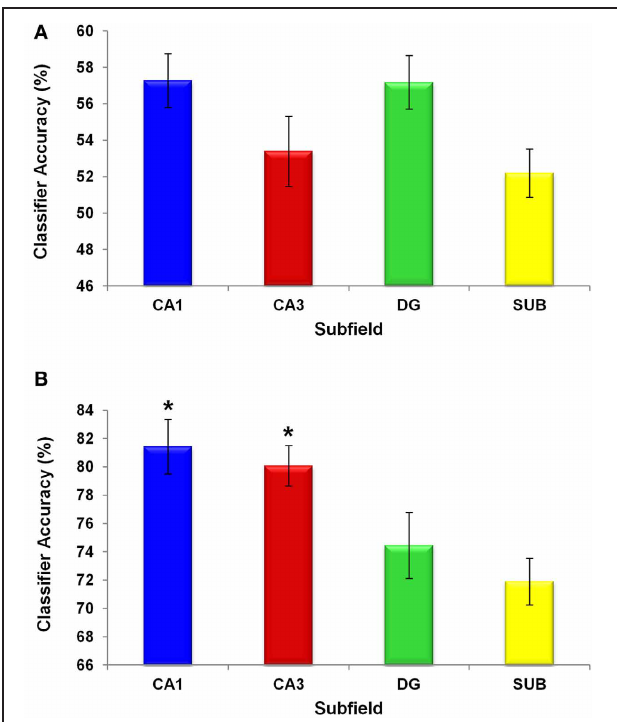
FIGURE 7 | Classifier performance in hippocampal subfields. Chance was 50%. Means ± 1 SE are shown. All subfield classifier performances were significantly above chance. The y axis shows the percentage accuracy of the classifiers (A) under perceptual certainty, when discriminating between the 100% A and 100% B scenes, and (B) under perceptual ambiguity, when making decisions about the 50% morphed scenes. Under perceptual ambiguity classifiers operating on voxels in both CA1 and CA3 showed significantly better performance ( ∗ p < 0 . 05) than those operating on voxels in DG and